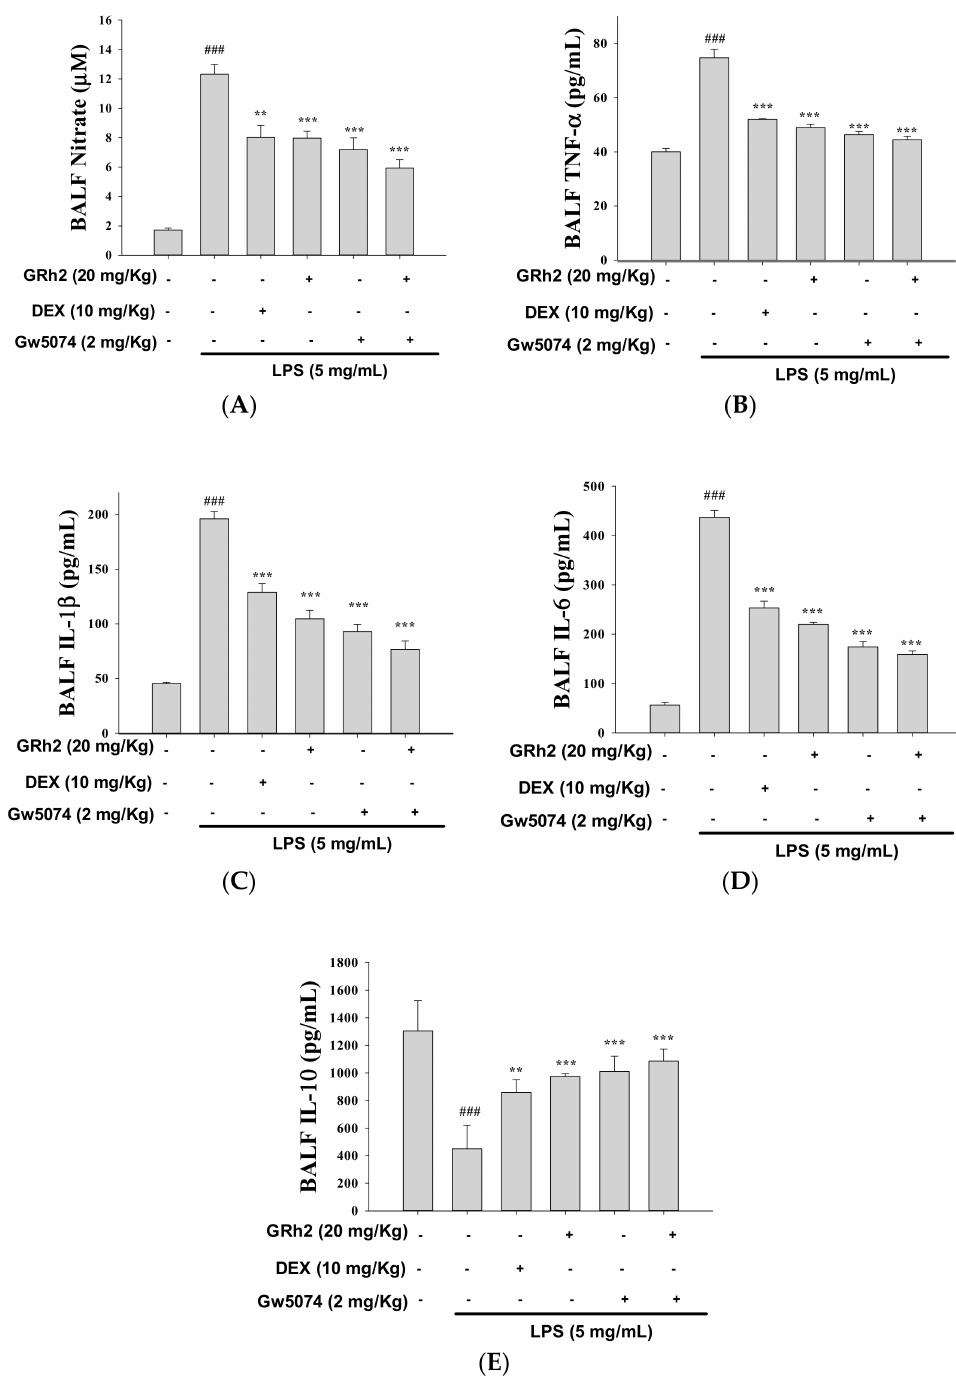
Figure 6. ( A ) GRh2 and Raf-1 inhibitor (GW-5074) reduced NO; ( B ) TNF- α ; ( C ) IL-1 β ; ( D ) IL-6; and ( E ) IL-10 in BALF. BALF was collected. NO, TNF- α , IL-1 β , IL-6, and IL-10 were detected at 6 h after LPS challenge by ELISA. Data are represented as mean ± S.E.M. ( n = 5). ### p < 0.001 compared with sample of control group. ** p < 0.01 and *** p < 0.001 compared with LPS-only